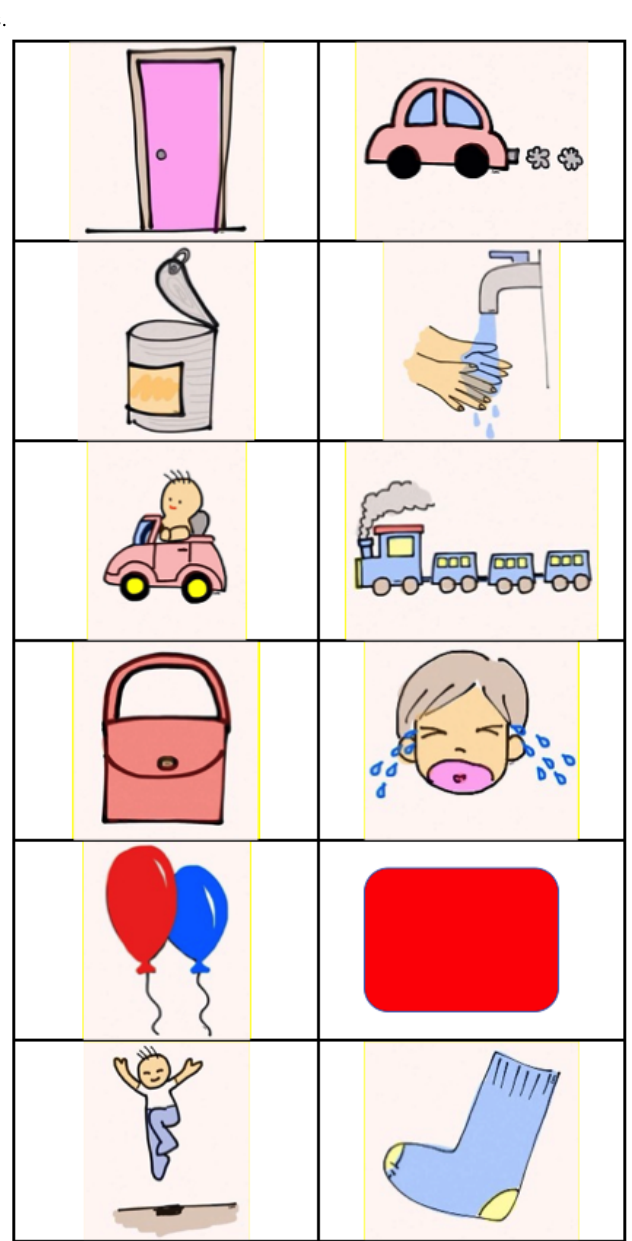
Figure 7. An example of picture